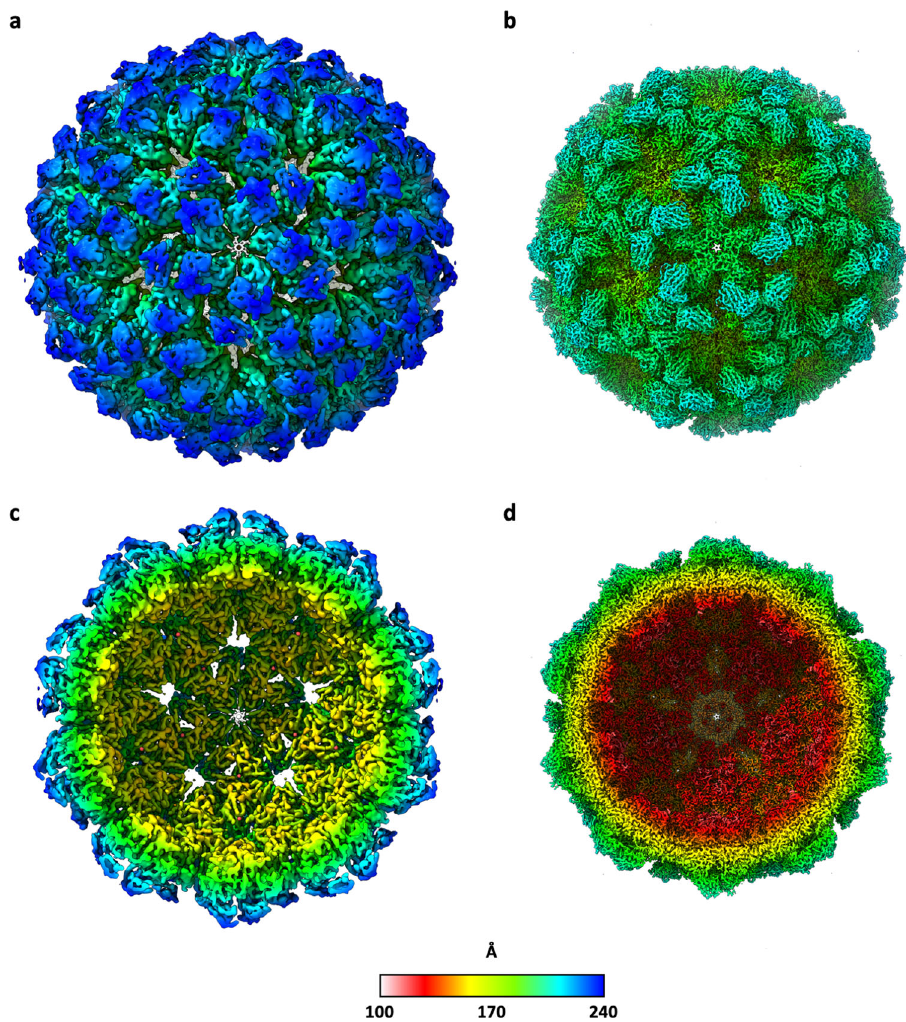
Fig. 4 Radially coloured cryo-EM reconstructions of N ω V VLPs highlighting the degree of compaction on transitioning from the procapsid to the capsid. Full and cutaway views of the procapsid reconstruction at 6.6Å resolution ( a , c , respectively), and for the capsid at 2.7Å resolution ( b , d , respectively) are shown as viewed down the icosahedral fi ve-fold axis. The surfaces are coloured with respect to the distance from the centre of each particle according to the key